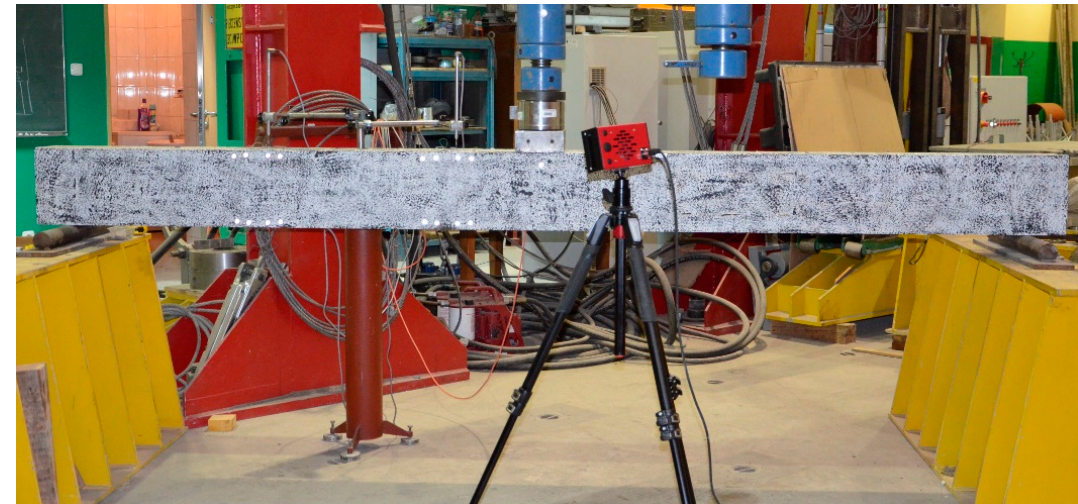
Figure 3. View of the tested beam covered with a black and white pattern.